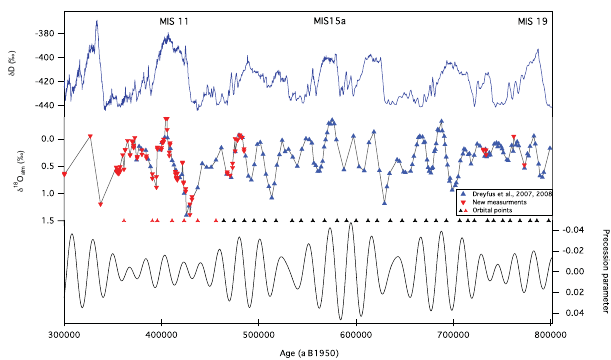
Fig. 1. EDC records between 300 and 800ka on the EDC3 age scale. Top: water stable isotope ( δ D) record with labeling of selected in- terglacial periods (Jouzel et al., 2007). Middle: complete record of δ 18 O atm , blue triangles from Dreyfus et al. (2007, 2008) and red triangles from this study. Bottom: precession parameter (here on a reverse y axis) obtained with the Analyseries software (Paillard et al., 1996), calculated using the Laskar et al. (2004) solution. Black points indicate the position of tie points between δ 18 O atm and precession parameter signals from Dreyfus et al. (2007); the red ones are from this study (Table